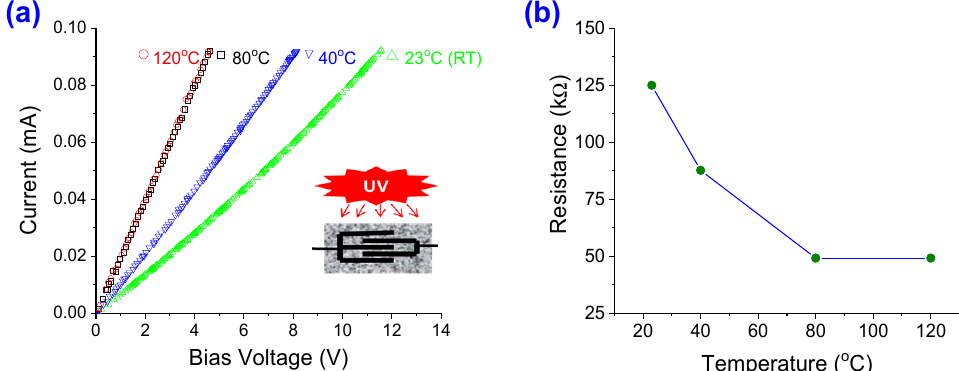
Figure 4. ( a ) Electrical current as a function of bias voltage at four di ff erent temperatures: room temperature (RT, 23 °C), 40 °C, 80 °C, and 120 °C. Inset: the schematic of the photodetector. ( b ) The temperature (RT, 23 ◦ C), 40 ◦ C, 80 ◦ C, and 120 ◦ C. Inset: the schematic of the photodetector. ( b ) The temperature e ff ect on the electrical resistance property of the In 2 O 3 prototype. temperature effect on the electrical resistance property of the In 2 O 3 prototype.